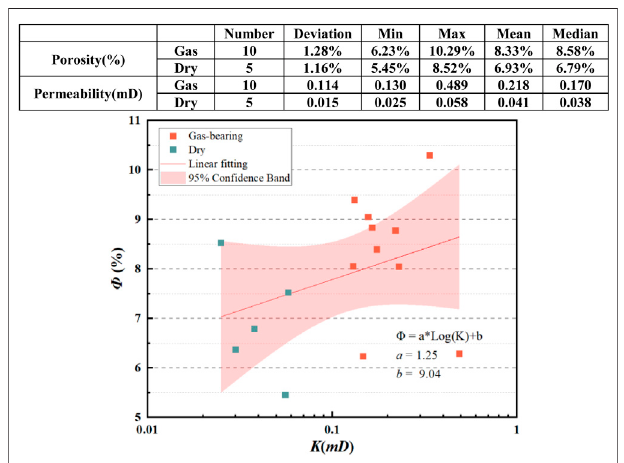
FIGURE 3 | The scatter plot showing the relationship between porosity and permeability of the Xujiahe Formation.